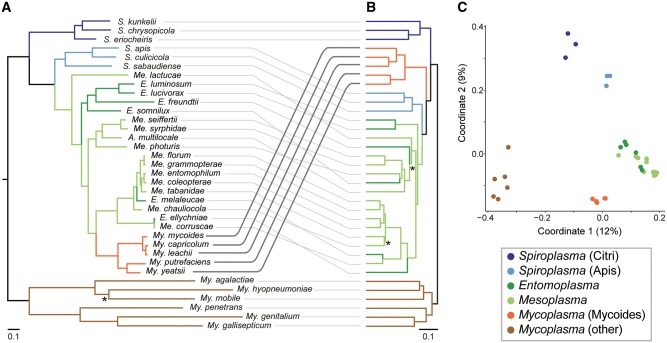
—Molecular phylogeny and gene content dissimilarity of the Mycoplasmatales–Entomoplasmatales clade lineages. (A) Maximum likelihood phylogeny based on 161 shared single-copy genes (71,550 aligned amino acid sites). One node with <98% bootstrap support is labeled with “*”. Bayesian inference based on the same concatenated alignment produced a phylogeny with identical topology and comparable levels of support. (B) Hierarchical clustering based on gene content. Two nodes with <80% support are labeled with “*”. Note the shift in position of the Mycoides clade lineages. (C) Principal coordinates analysis of gene content. The % variance explained by each axis is provided in parentheses.